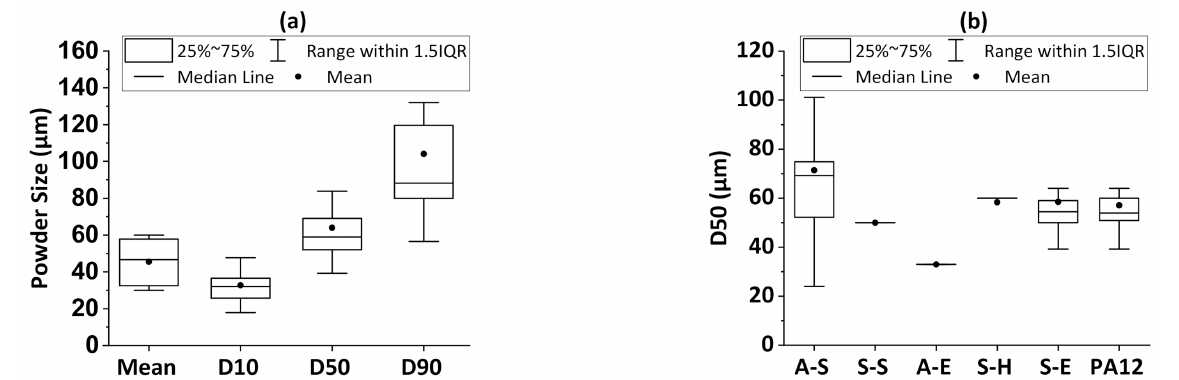
Figure 5. Range of reported polymer powder size characteristics: ( a ) statistics on the reported powder sizes as mean, D10, D50, and D90 values [11–111] ( b ) D50 values of polymer powders used in L-PBF of Amorphous Standard (A-S) including polymers such as TPU, PS, PMMA; of Semicrystalline Standard (S-S) including polymer as HDPE; Amorphous Engineering (A-E) including polymer as PDLLA; Semi-Crystalline High-performance (S-H) including polymers such as PEEK, PEK, PEKK; Semi-Crystalline Engineering (S-E) including polymers such as PBT, PA6, PA11, PA12, and PA12 powder feedstocks. Outlier points are not shown in